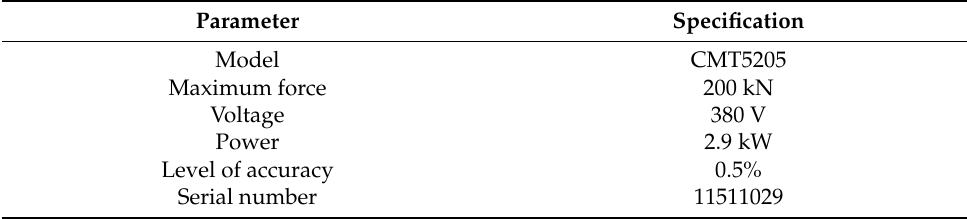
Table 2. Specifications of the universal tensile testing machine.